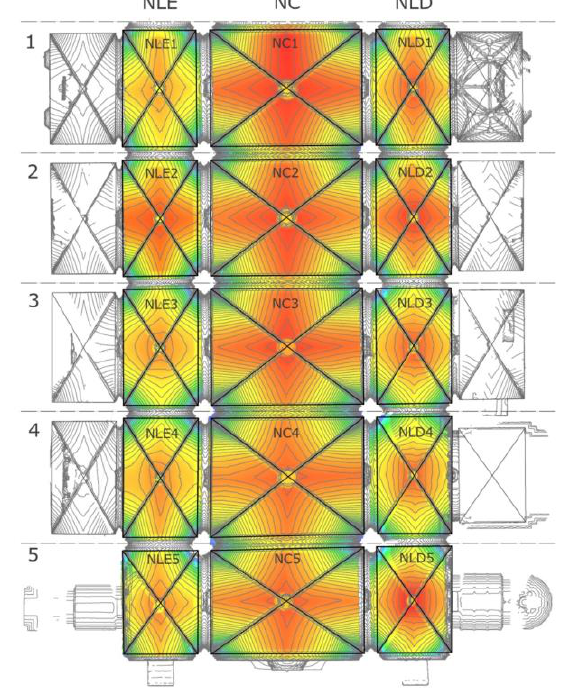
Figure 6. Topography and ranges of the vaults’ heights.